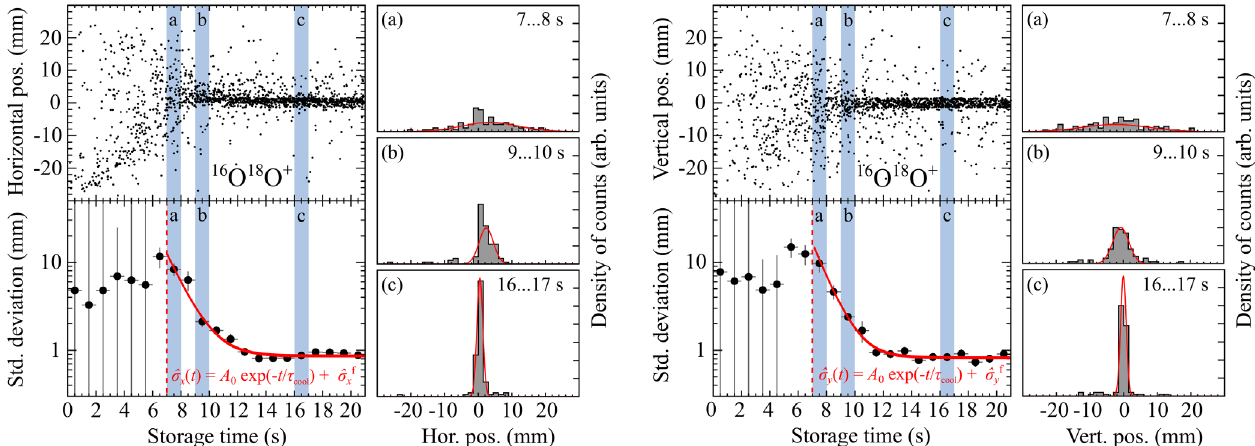
FIG. 3. Transverse electron cooling of 16 O 18 O þ at 2.7 MeV ( 79 keV = nucleon). The left and right subfigures show the horizontal ( x ) and vertical ( y ) ion motions, respectively. Electron cooling started directly at ion injection (0 s storage time). Recombination of the molecular ion in the cooler led to neutral fragments 16 O and 18 O that were detected via neutral-fragment imaging. The top left frames show the distribution of the reconstructed centers-of-mass (c.m.) of these fragments as a function of storage time. The density of dots in the histogram is proportional to the density of hits on the detector. For 1-s time intervals, normal distributions were fit to the vertical and horizontal c.m. histograms, as exemplified in frames (a), (b), and (c). The obtained standard deviations are shown in the lower left frames. From 7 s of storage time, the evolution of the horizontal and vertical beam envelopes can be fit by an exponential decay (solid red curve), yielding the cooling times τ and final envelope sizes ˆ σ f (see text). cool